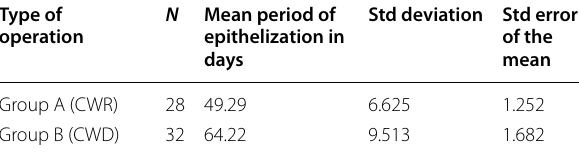
Table 6 The average period of